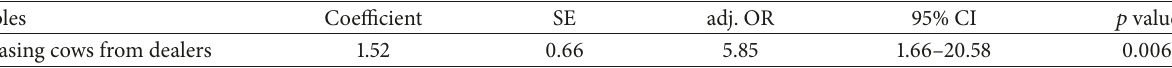
Table 2: Results of multiple logistic regression